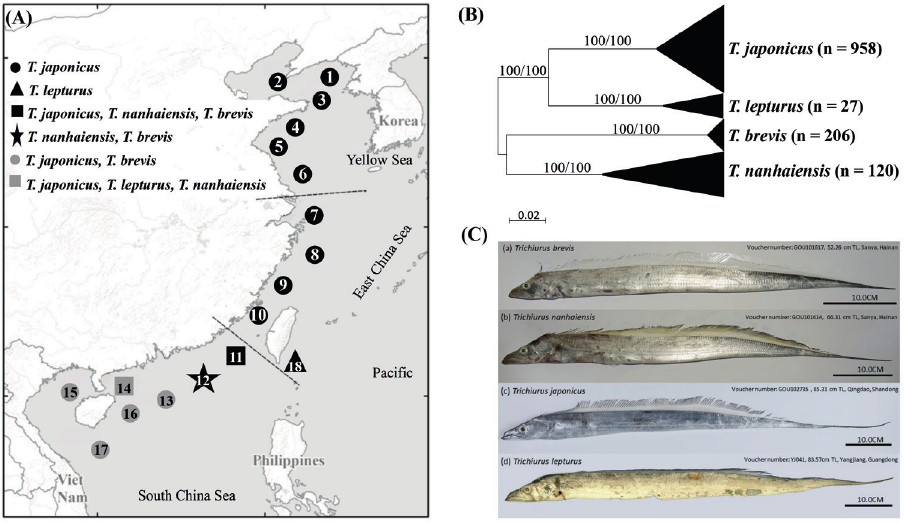
Figure 1. A Eighteen sampling localities of the genus the Trichiurus along the Chinese coast and the species composition after our surveys. Refer to Suppl. material 1: Table S1 for the abbreviations of locali- ties. B The maximum-likelihood (ML) tree of these four Trichiurus species along the coast based on the COI gene. The numbers at the nodes are bootstrap values of the ML and NJ (neighbor-joining) analyses. The sampling size (n) indicated in parentheses C The photographs of four Trichiurus species used in the mitogenomes